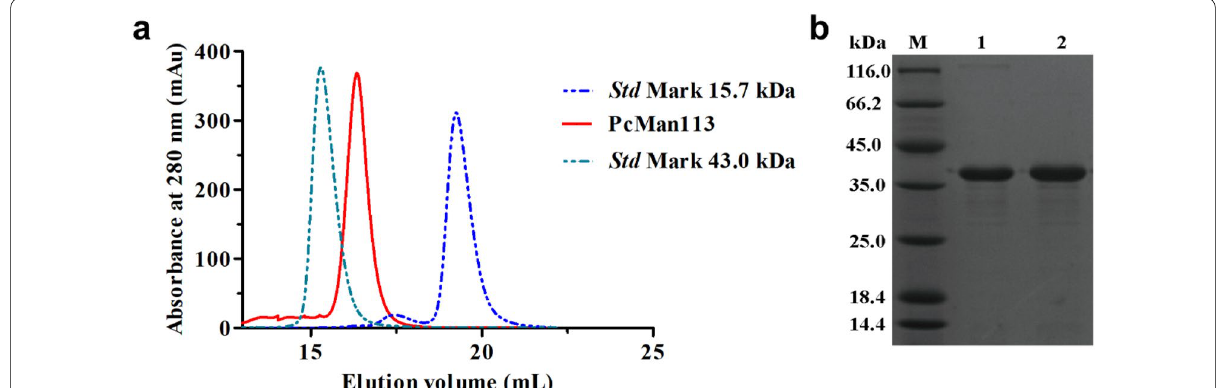
Fig. 2 Purification of PcMan113 by size‑exclusion chromatography ( a ) and SDS‑PAGE analysis of purified recombinant PcMan113 ( b ). Lane M: marker; lane 1–2: the PcMan113 purified by size‑exclusion